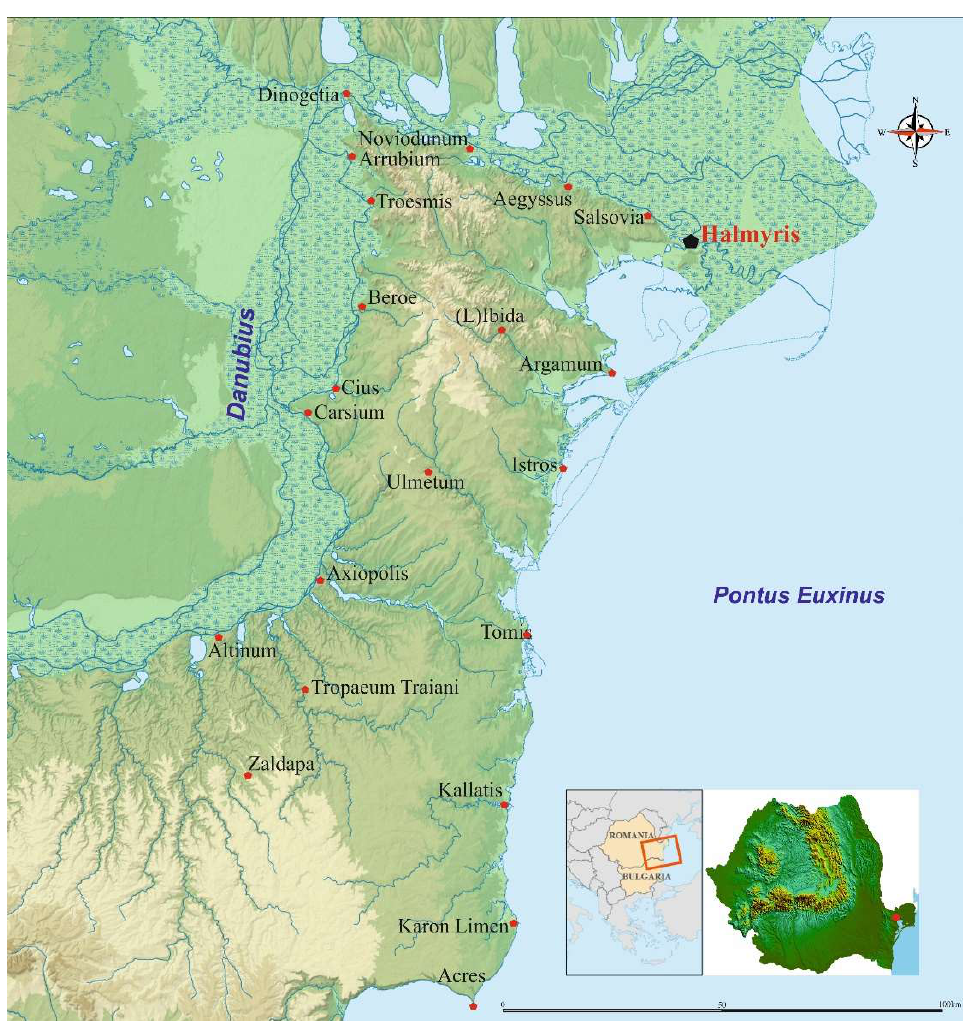
Figure 1. Map of Scythia Minor indicating the location of Halmyris settlement (black dot). The first phase of habitation has been dated to the 4th–1st centuries BC, although an Oriental Greco-bowl, a fishplate, and fragments of Mende and Chios amphorae together with handworked pottery would indicate an even earlier habitation. The second phase of habitation corresponds to early Roman settlement (1st–3rd centuries AD) when a castrum was built and the settlement was one of the main statio of the classis Flavia Moesica, the fleet of the Danube and the Pontus. In the first years of the 2nd century AD, the first Roman stone fortification was built at Halmyris. The shape of this fort was rectangular (181 × 120 m), and it housed an auxiliary unit and mariners of the Moesian fleet, next to a civilian settlement ( vicus classicorum ) [42]. In the late 3rd century, the Halmyris